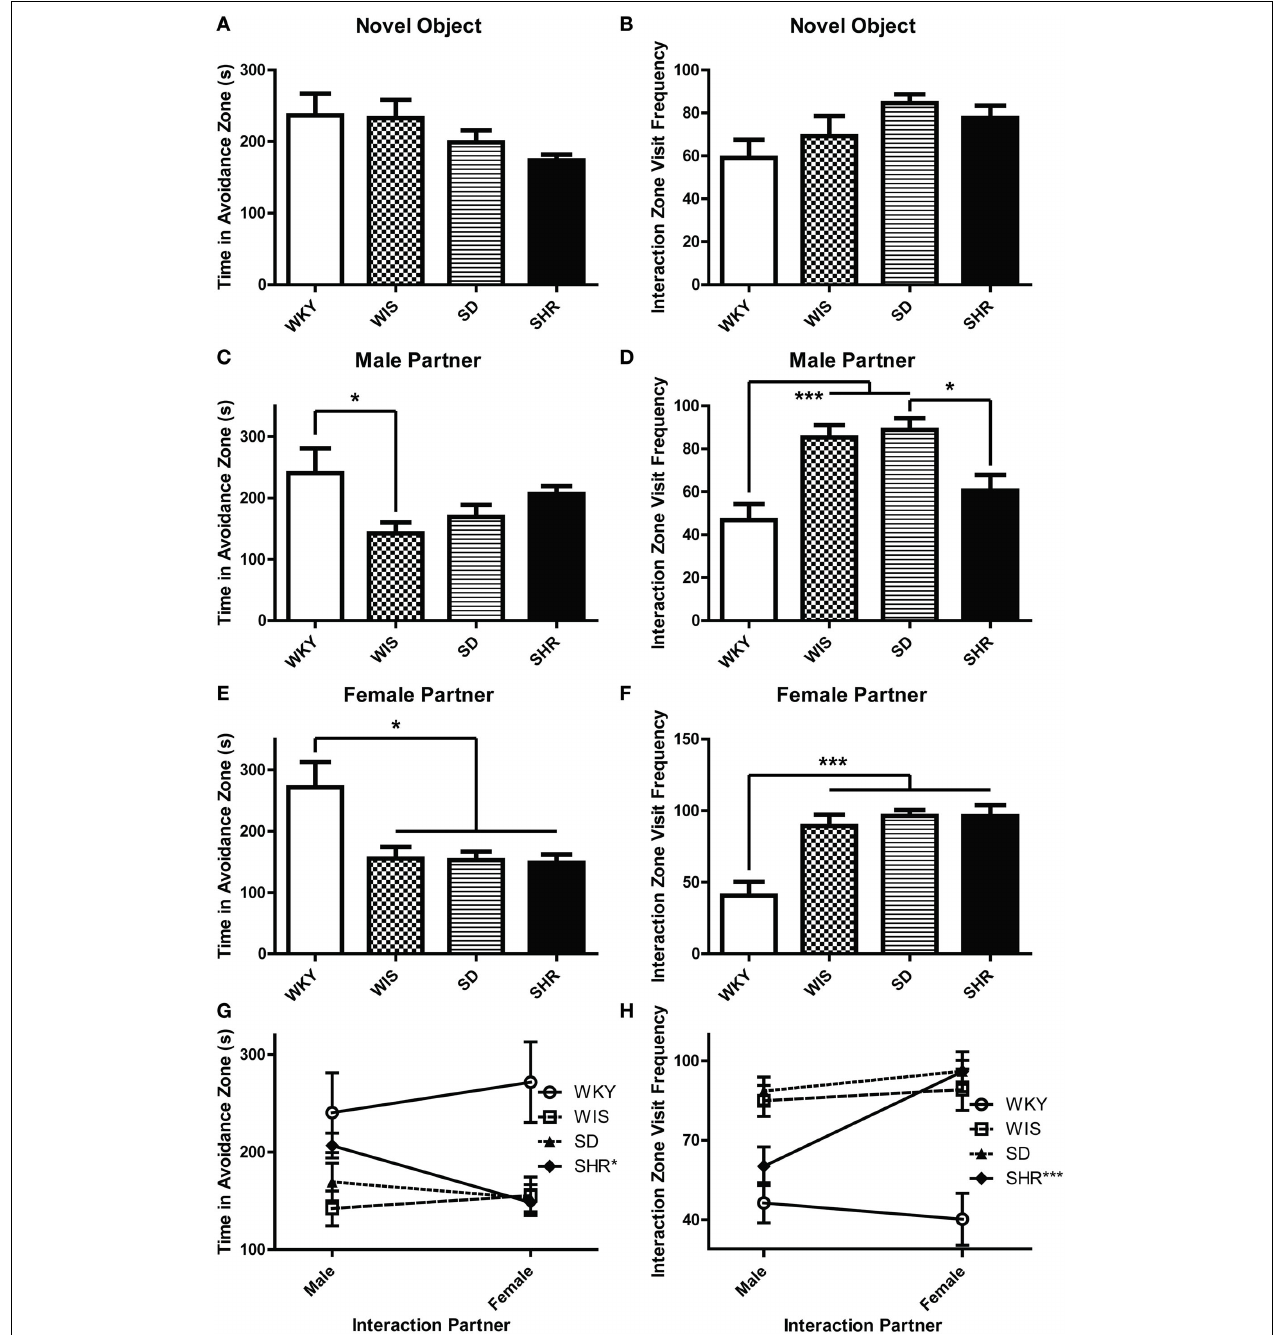
FIGURE 1 | WKY rats exhibit social interaction deficits relative to other rat strains. Social interaction behavior was examined in adult male Wistar Kyoto (WKY), Wistar (WIS), Sprague–Dawley (SD), and Spontaneously Hypertensive (SHR) rats. During the three social interaction test sessions, experimental animals encountered a novel object (test day 1), a novel male stimulus rat (test day 2), or a novel female stimulus rat (test day 3). During the first session, all strains spent similar amounts of time in an avoidance zone farthest away from the novel object (A) ; all of the rats also spent similar lengths of time in a designated interaction zone that was within 2-cm of the novel